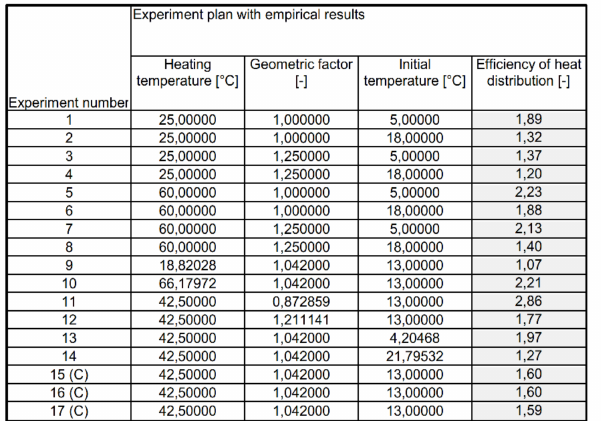
Figure 14. List of empirically determined heat distribution coefficients for the PCM composite with coke recyclate.